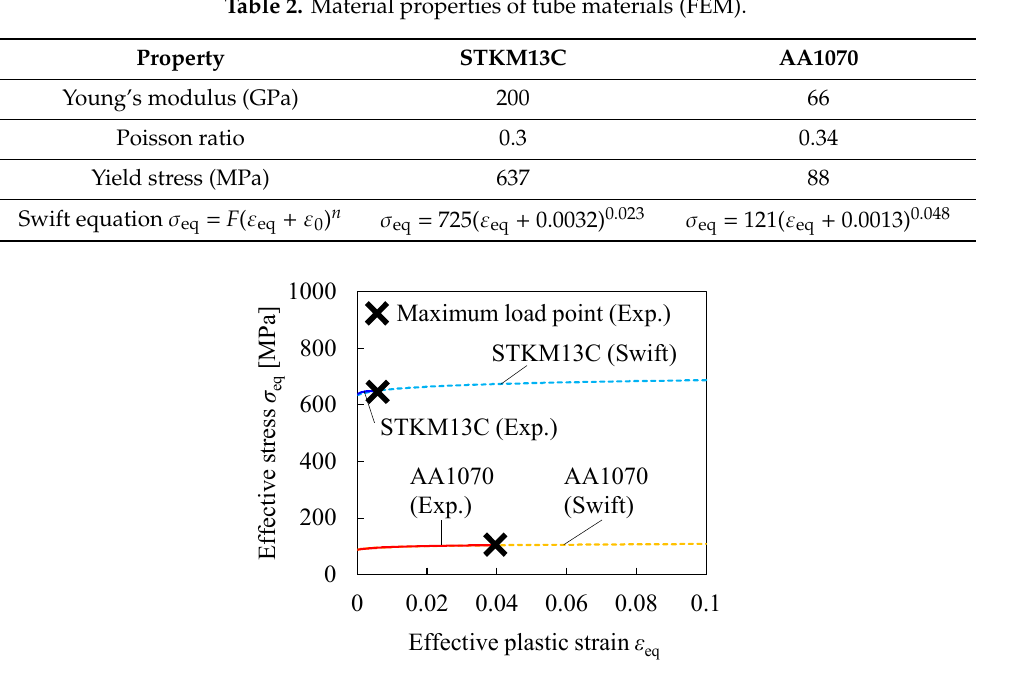
Figure 5. E ff ective stress σ eq vs. e ff ective plastic strain ε eq curves of STKM13C and Figure 5. Effective stress σ eq vs. effective plastic strain ε eq curves of STKM13C and AA1070.